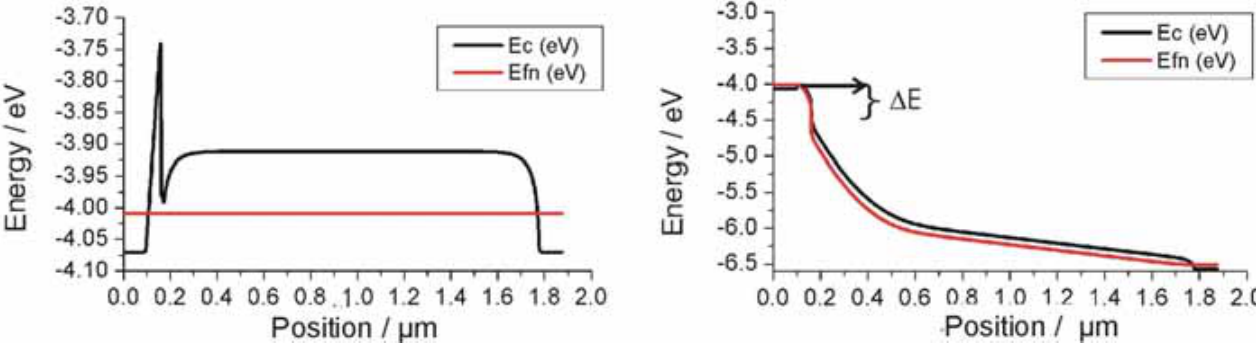
Figure 7. Band structure across the Gunn diode according to Table 1: without supply voltage (left) and with supply voltage (right).